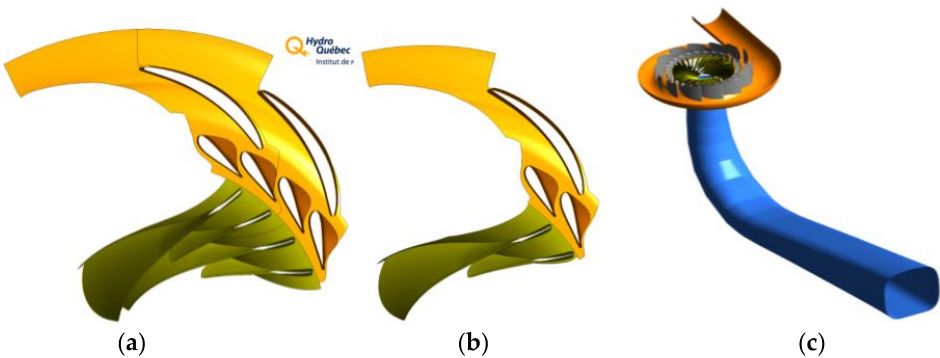
Figure 23. Comparison of flow modeling approaches applied to a Francis turbine; ( a ) configuration used for the Fourier transform; ( b ) configuration used for the profile transform; ( c ) configurations show the complete turbine [6]. Energies 2016 , 9 , 74